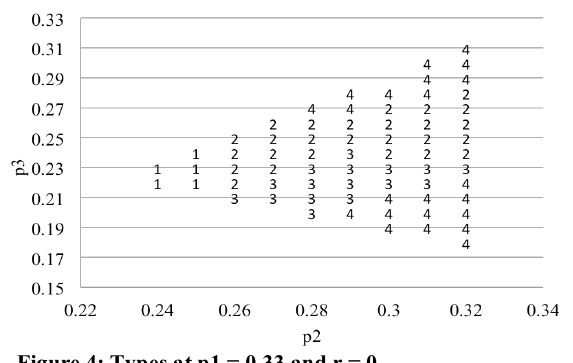
Figure 3(b): Types at p1 = 0.65 and r = 0